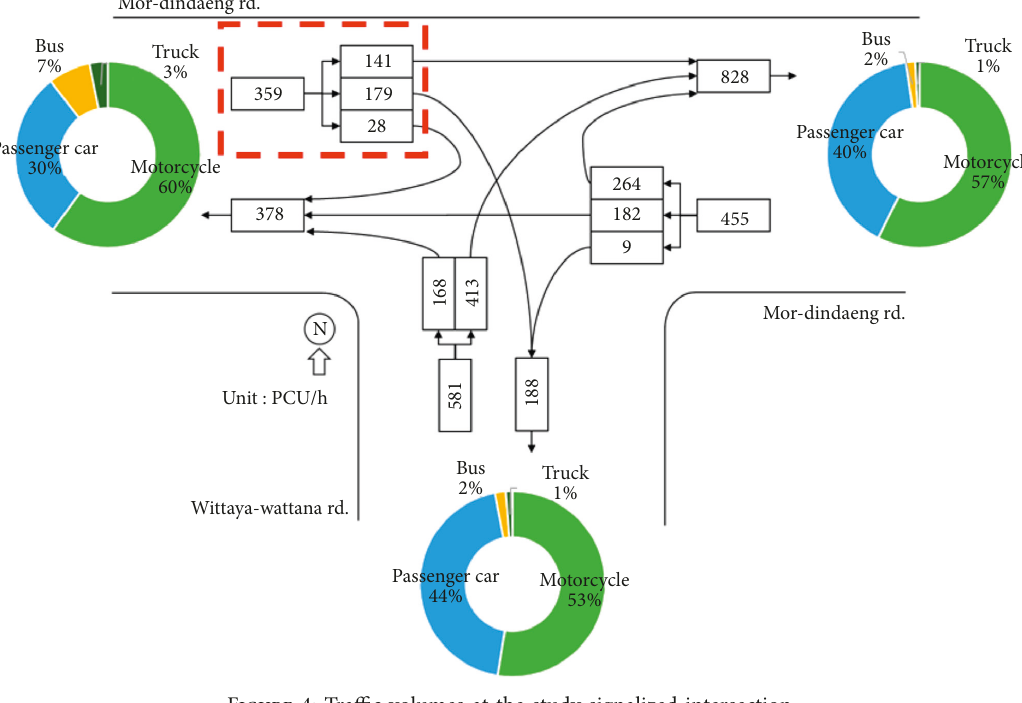
Figure 4: Traffic volumes at the study signalized